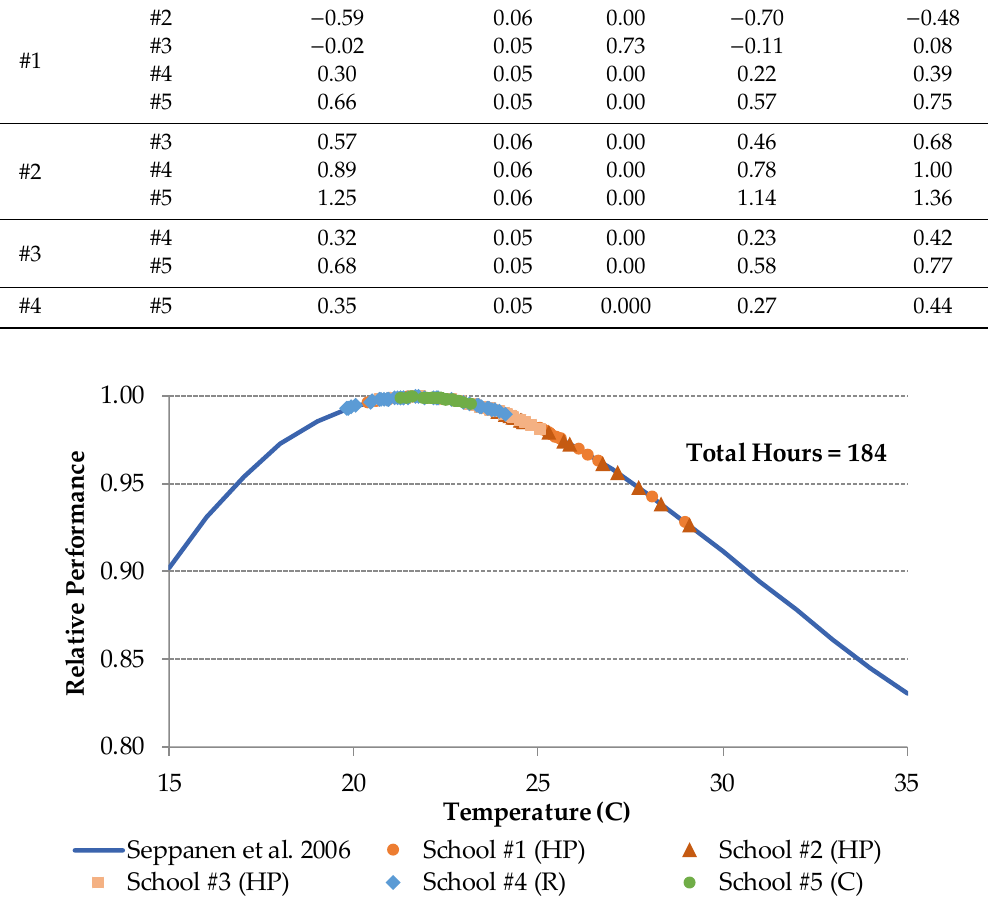
Figure 5. Hourly Indoor Temperature and Relative Performance Analysis.